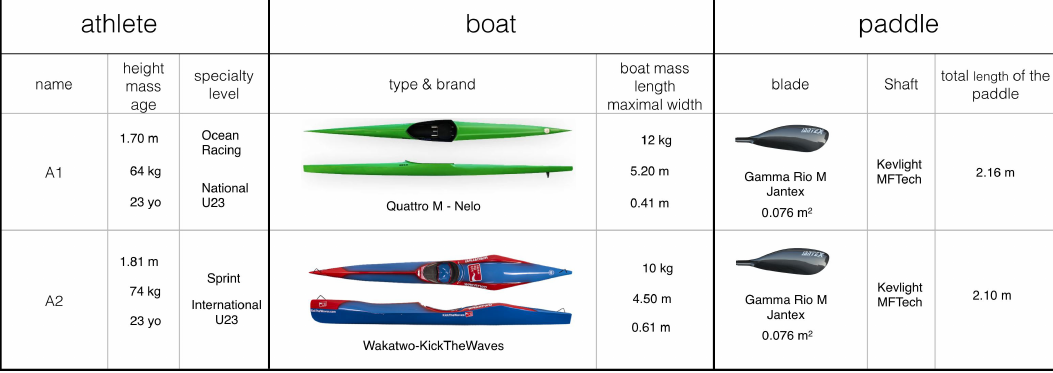
Figure 2. Main characteristics of the athletes, boats, and paddles used in the